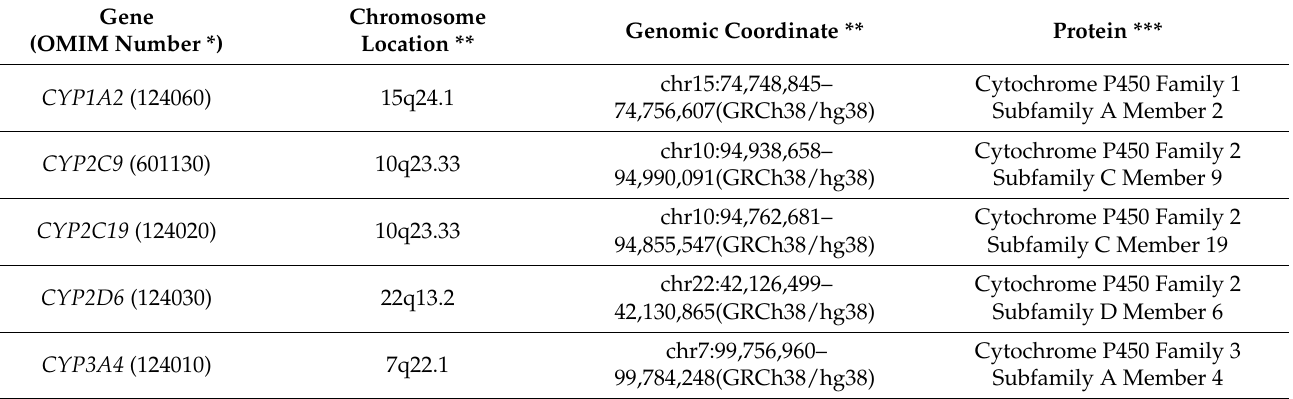
Table A4. Candidate genes encoding key enzymes in antipsychotic metabolism.